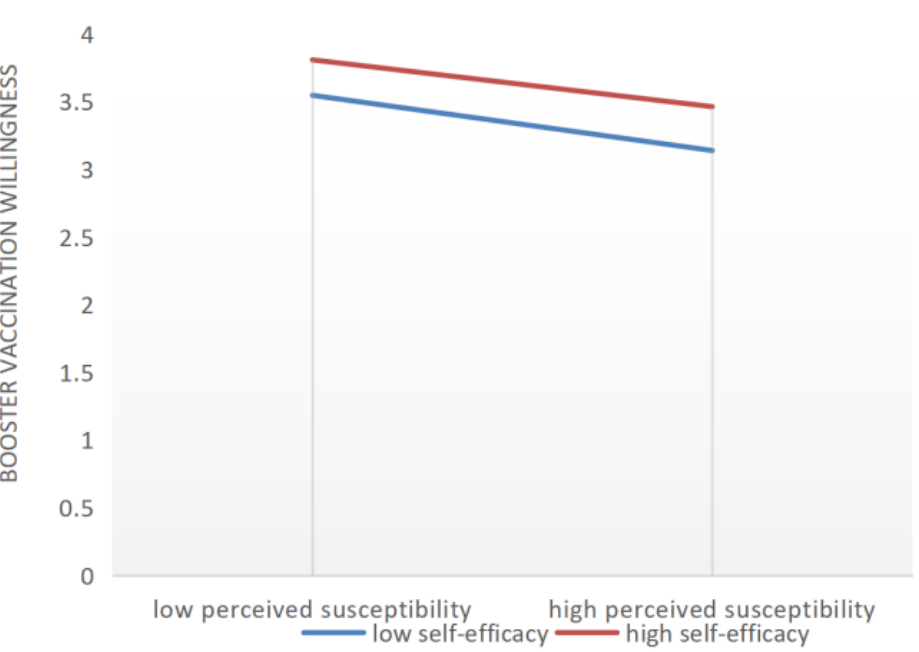
Figure 1. The moderating effects of self-efficacy on the relationship between perceived susceptibility and booster vaccination intention.